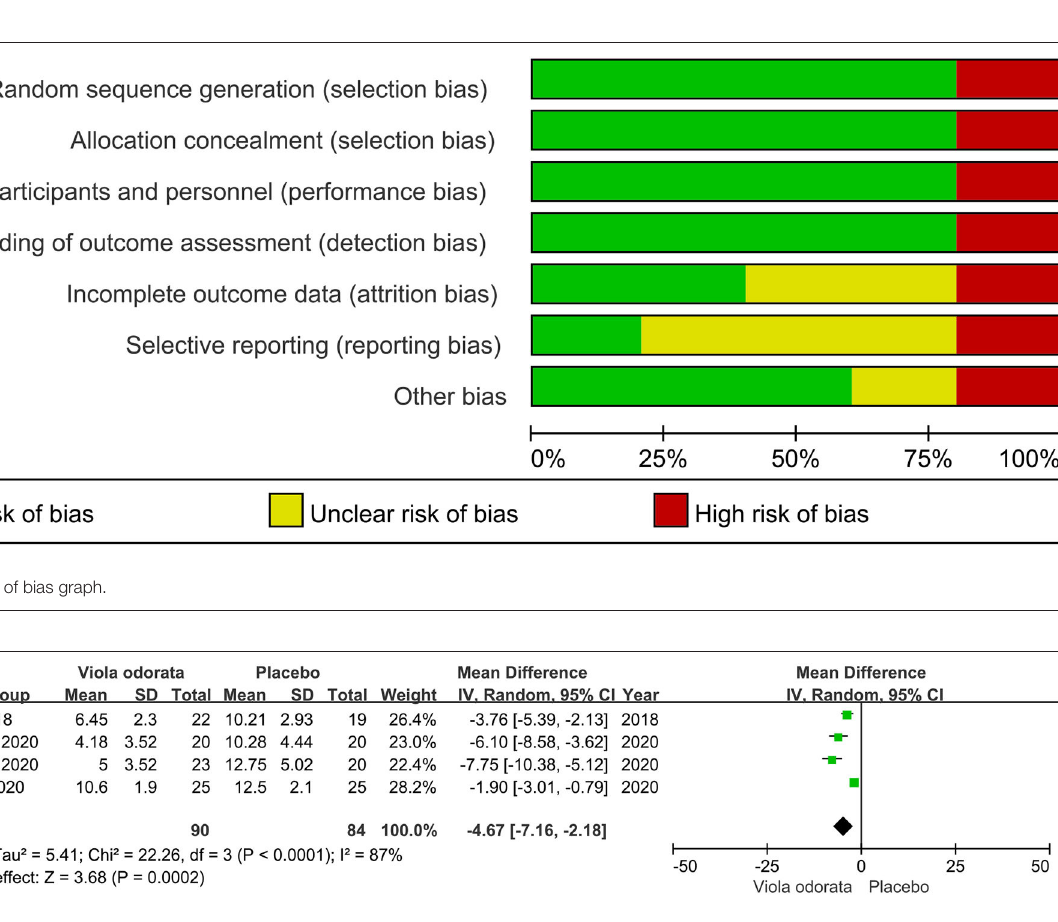
FIGURE 4 | Forest plots showing results in total PSQI scores. PSQI, pittsburgh sleep quality index; SD, standard deviation; IV, inverse variance; df, degrees of